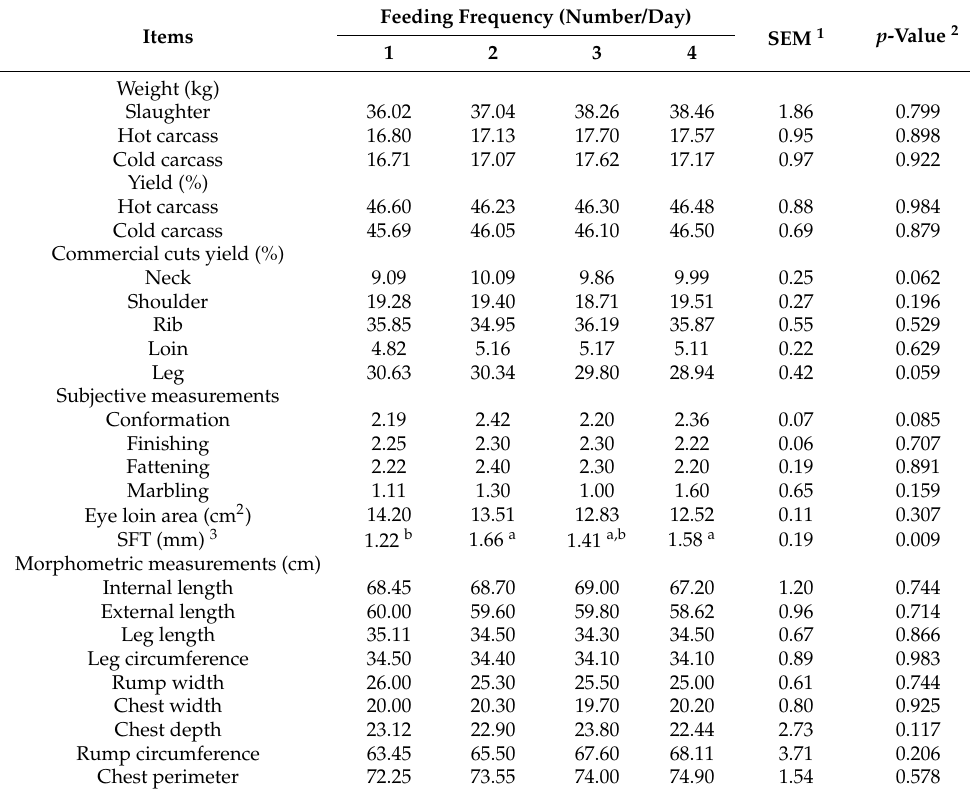
Table 4. Quantitative, subjective, and morphometric measurements of the carcass of male feedlot lambs subjected to different frequencies.